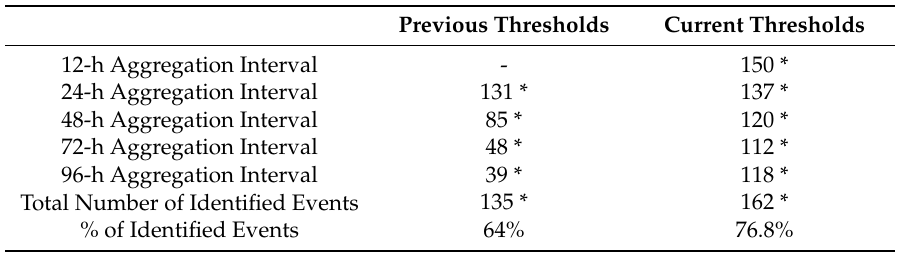
Table 6. The ERDS performance (a comparison between the results obtained with the previous thresholds and with the current ones).